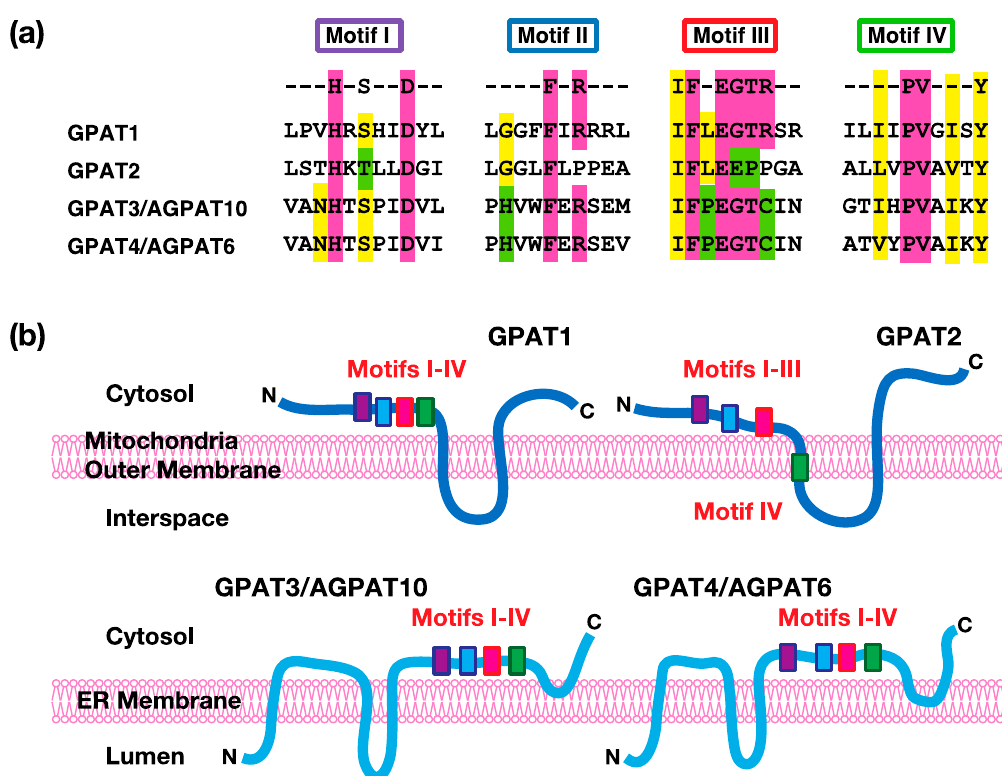
Figure 2. The acyltransferase motifs and predicted transmembrane topology in acyl-CoA:glycerol- sn -3- phosphate acyltransferases (GPATs). ( a ) The conserved amino acid residues of the acyltransferase acyltransferase motifs of GPATs. The transmembrane segments of each enzyme were predicted by